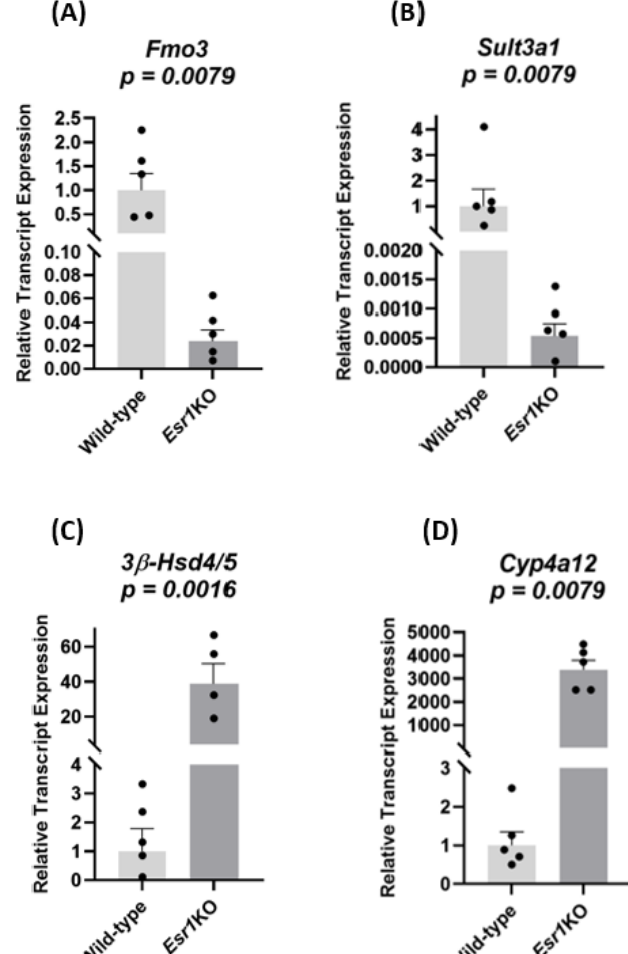
Figure 2. Pairwise analysis shows liver transcripts affected by Esr1 knockout in females are largely sex-specific. Pairwise analysis showing log 2 fold-change in transcript expression from microarray analysis comparing Estrogen Receptor- α ( Esr1 ) dependent transcripts in females with sex-specific transcripts. All transcripts that changed at least two-fold in either comparison were included ( n = 988). Each set of transcripts represents microarray results from a pool of livers from individual mice sacrificed at 9–10 weeks of age. Wild-type (WT) females are represented by a pool of C57BL/6J (B6) females ( n = 18) and WT female littermates of the Estrogen Receptor- α KO mice ( n = 6) and Estrogen Receptor- β KO mice ( n = 6). Estrogen Receptor- α KO females are represented by a pool of intact individuals ( n = 6) and females that underwent a sham operation ( n = 6). Among the 45 genes most differentially expressed between WT and Esr1 KO mice, other than Esr1 , 6 are strongly associated hepatocarcinogenesis: A1bg , Fmo3 , Cabyr , Cspg5 , Mthfd1l , Tff3 (Table 4). A1bg and Fmo3 , which are expressed more highly in WT females, are associated with protection. A1bg produces an antisense RNA that is under-expressed in HCC in patients with poor prognosis and reduces the malignancy of HCC cells when Table 4. Esr1 -regulated genes implicated in hepatocarcinogenesis. overexpressed [27]; Fmo3 is one of 6 lipid-metabolism-related genes that together predict the prognosis of HCC patients [28]. Cabyr , Cspg5 , Mthfd1l and Tff3 are expressed more highly in Esr1 KO females and are associated with susceptibility. All are overexpressed in HCC. Gene Cabyr also reduces cell proliferation when knocked down in liver cancer cells [29]; Cspg5 is one of 6 genes that, together, predict HCC patient survival [30]; Mthfd1l predicts HCC patient survival [31]; Tff3 also predicts HCC patient survival, and changing its expression in HCC cells affects the cells’ oncogenicity